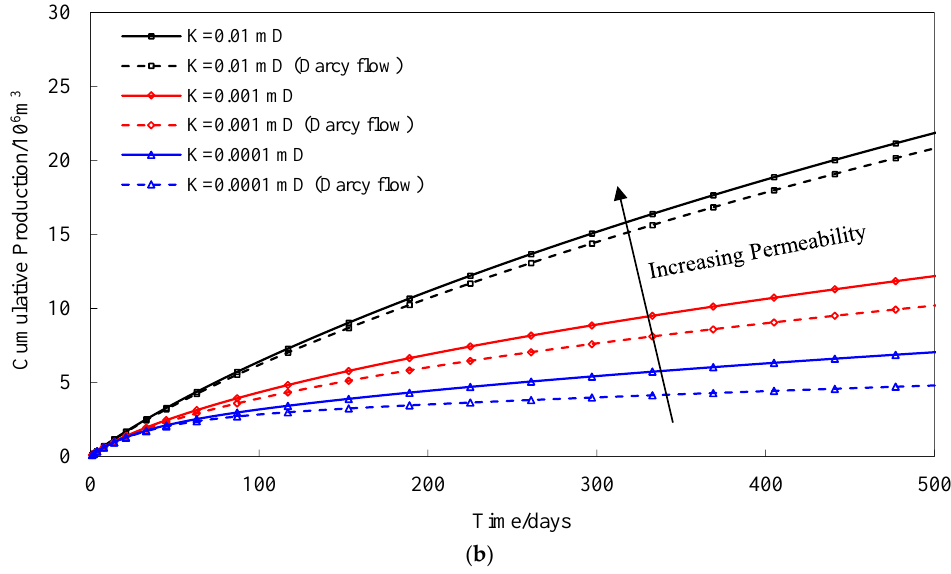
Figure 13. Effects of non-Darcy flow in multiscale shale matrix under different permeabilities of shales (solid lines in this figures represent gas production rate and cumulative production with considering the non-Darcy flow effects, dashed lines in this figure represent gas production rate and cumulative production only considering Darcy flow or viscous flow.) ( a ) Production rate under different shale permeabilities; ( b ) Cumulative production under different shale permeabilities.